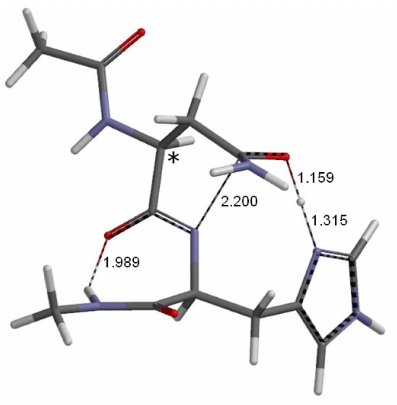
Figure 4. The optimized geometry of TS1, the transition state of the first step (cyclization) ( ϕ N = ´ 169 ˝ , ˝ , χ ˝ , ϕ ˝ , ψ ˝ , χ ˝ ). Relevant interatomic distances are shown ψ N = ´ 158 1N = 170 H = ´ 83 H = 78 1H = ´ 59 in Å. The asterisked carbon corresponds to the Asn α carbon in the reactant R.